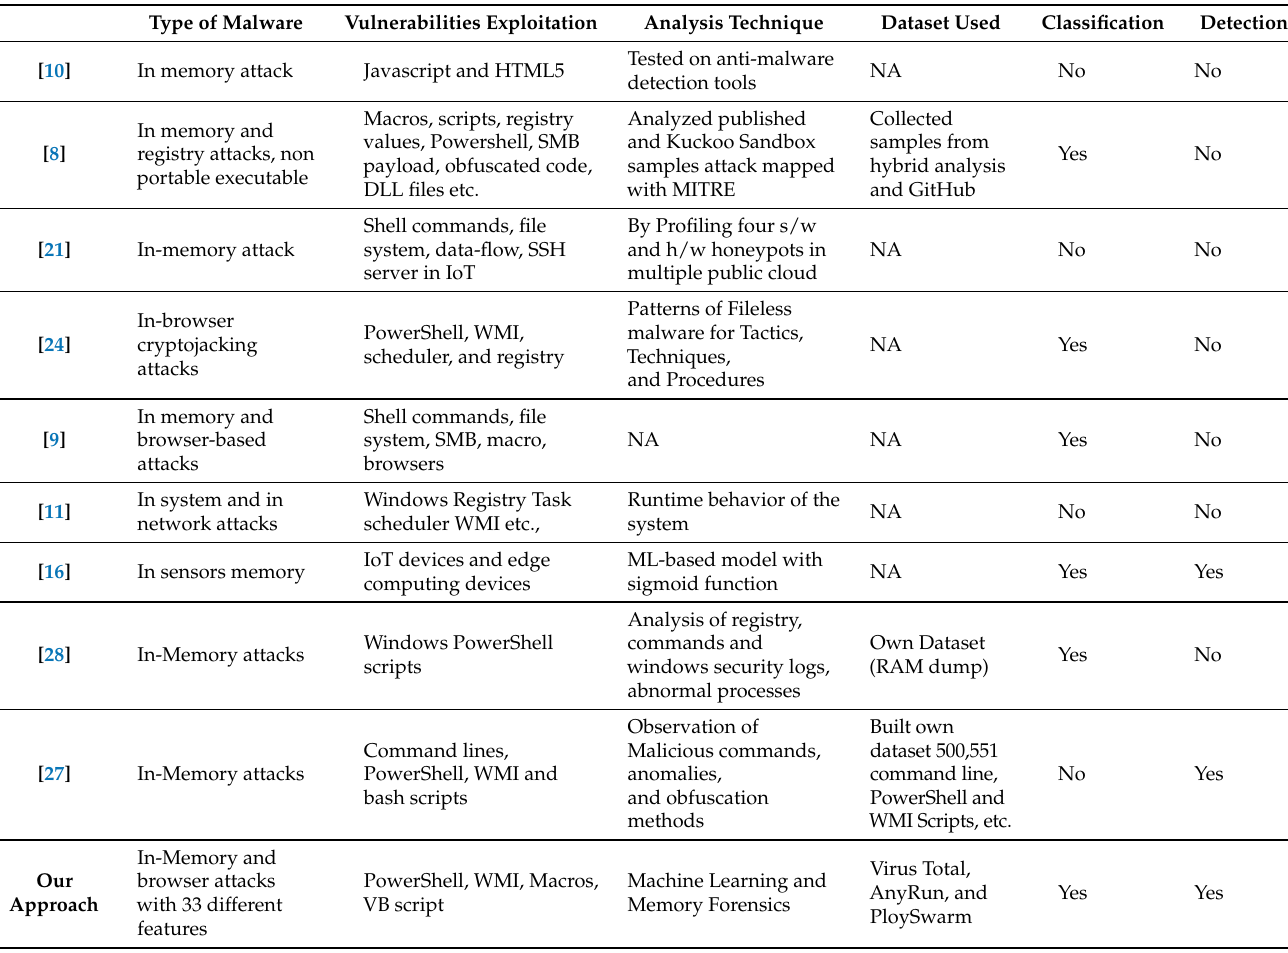
Table 1. Comparison of the proposed approach with state-of-the-art